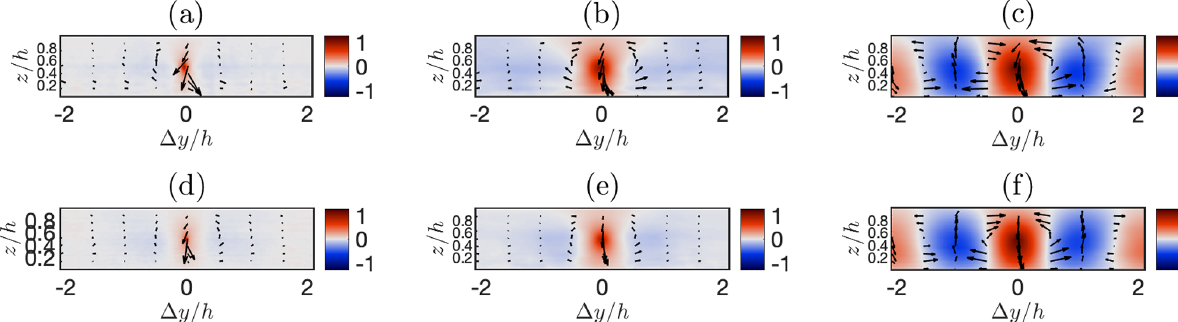
Figure 9. Visualization of the conditionally averaged velocity field in the cross-stream vertical plane at (cid:49)x/h = 0 from simulations FV64 (a) , FV64* (b) , PSFD64 (c) , FV160 (d) , FV160* (e) , and PSFD160 (f) . The conditional event is a positive streamwise velocity fluctuation at (cid:49)x/h = 0, (cid:49)y/h = 0, and z/h = 0 . 5. Colors are used to represent the magnitude of the streamwise component and vectors denote the cross-stream and vertical components.